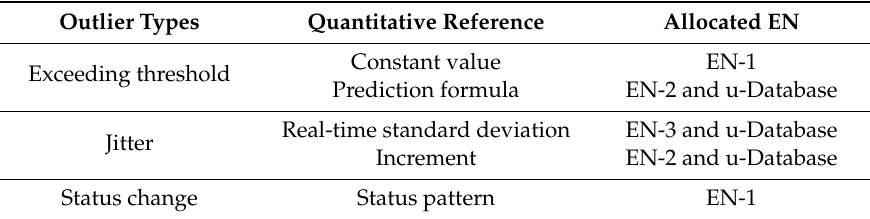
Table 1. Outlier type abstracts and